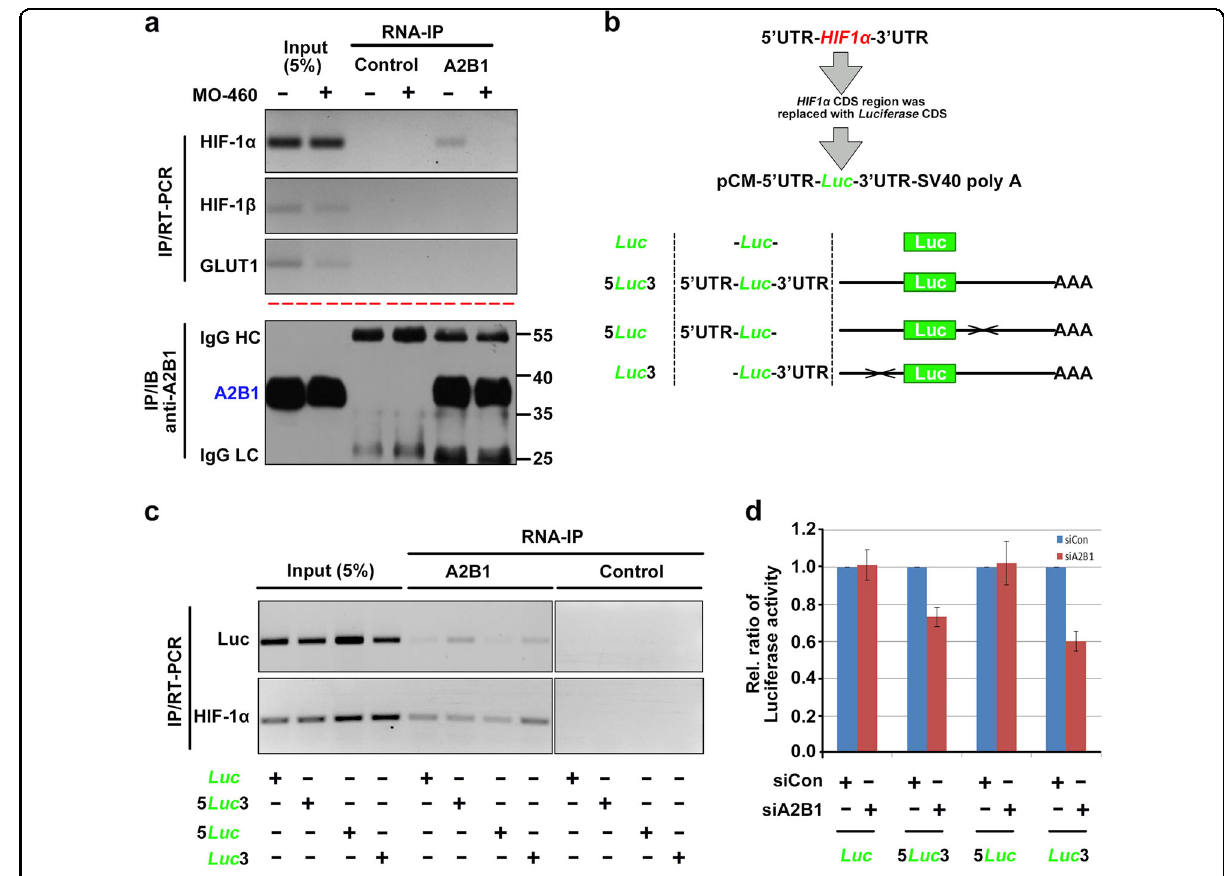
Fig. 4 Inhibitory effect of MO-460 mediated by direct interaction of hnRNPA2B1 with the 3 ’ -UTR of HIF-1 α mRNA. a Effect of MO-460 on RNA-immunoprecipitation with hnRNPA2B1 and HIF-1 α mRNA. HIF-1 β and GLUT1 are used to negative controls. b Schematic of luciferase